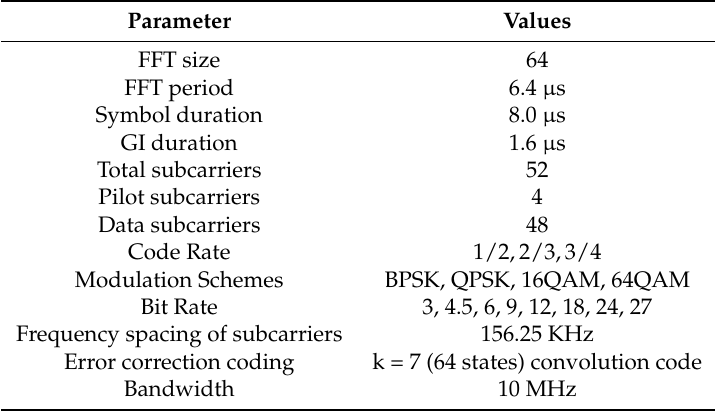
Table 1. IEEE 802.11p standard parameters.